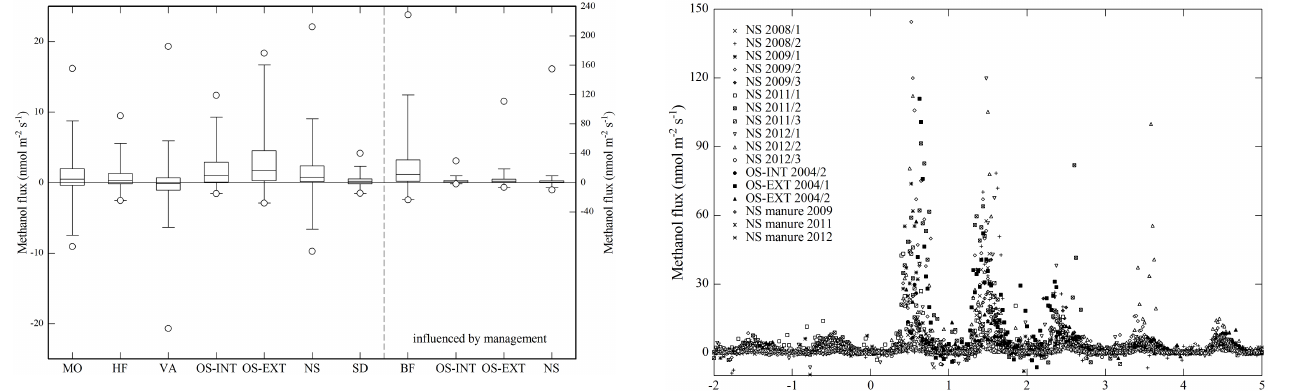
Figure 2. Box plots of methanol fluxes at the eight study sites. The left y axis refers to sites/measurements not influenced by site management events, while the right y axis (note differing scaling) shows data for Blodgett Forest and the grassland sites inclusive of measurements during/after management (MO: Missouri Ozark; HF: Harvard Forest; VA: Vielsalm; OS-INT: Oensingen – intensive; OS-EXT: Oensingen – extensive; NS: Neustift; SD: Stordalen; BF: Blodgett Forest). Box plots show minima/maxima (circles), 5 and 95% quartiles (whiskers), the interquartile range (box) and the me- dian (horizontal line).